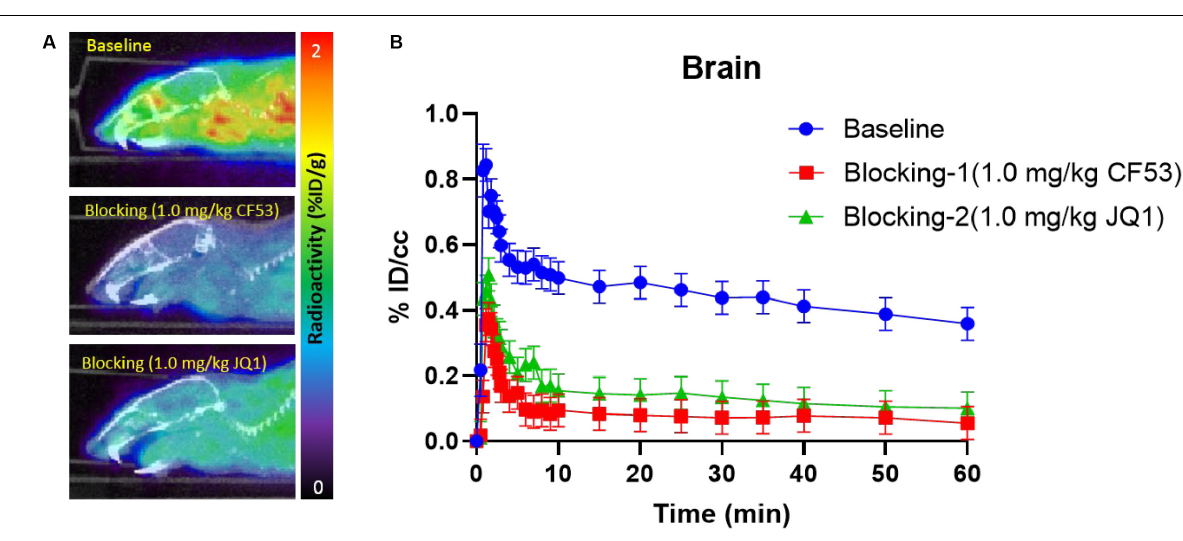
FIGURE 4 | (A) The mice brain PET/CT imaging of [ 11 C]1 focuses on the brain and the baseline and blocking (1.0 mg/kg CF53 and 1.0 mg/kg JQ1) (B) time-activity curves of [ 11 C]1 (The images are summed from 20 min to 60 min, n =